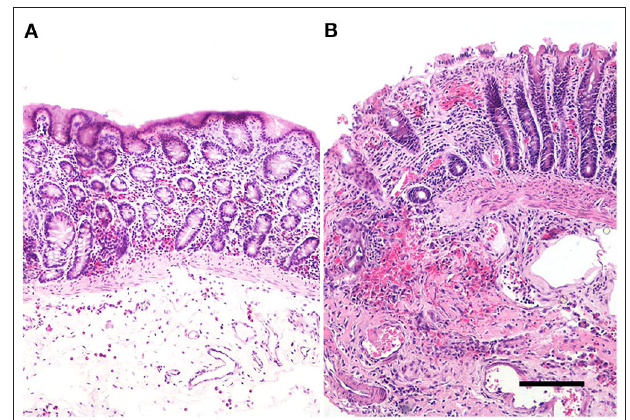
FIGURE 1 | Equine pelvic flexure Histology. Representative sections of two cases of different degree of severity. (A) Mucosal and submucosal lesions of mild severity, represented by mild mucosal hemorrhages and moderate submucosal oedema, in association to a mild inflammatory lymphoplasmacytic infiltrate; (B) mucosal and submucosal lesions of severe injury. In the mucosa, the luminal epithelium show a severe and diffuse superficial loss, multifocal haemorrages and a severe lymphoplasmacytic infiltrate. In the submucosa is also observed a severe hemorrhage and a moderate chronic inflammatory infiltrate. Haematoxylin & Eosin (H&E); scale bar, 200 µ